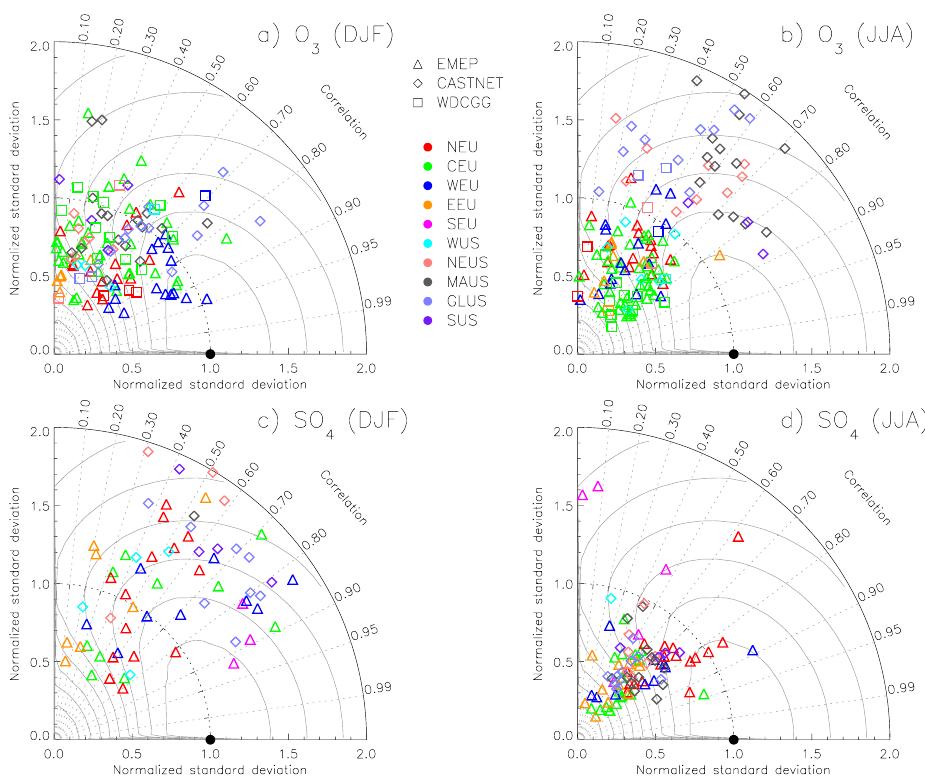
Fig. B2. Taylor diagrams comparing the ECHAM5-HAMMOZ SREF simulation with EMEP, CASTNET, and WDCGG observations of O 3 seasonal means (a) DJF and (b) JJA) and SO 2 − seasonal means (c) DJF and (d) JJA. The black dot is used as a reference to which simulated 4 fields are compared. Continuous grey lines show iso-contours of skill score. Stations are grouped by regions as in Fig. 1: Northern Europe (NEU); Central Europe (CEU); Western Europe (WEU); Eastern Europe (EEU); Southern Europe (SEU); Western US (WUS): North-Eastern US (NEUS); Mid-Atlantic US (MAUS); Great lakes US (GLUS); Southern US